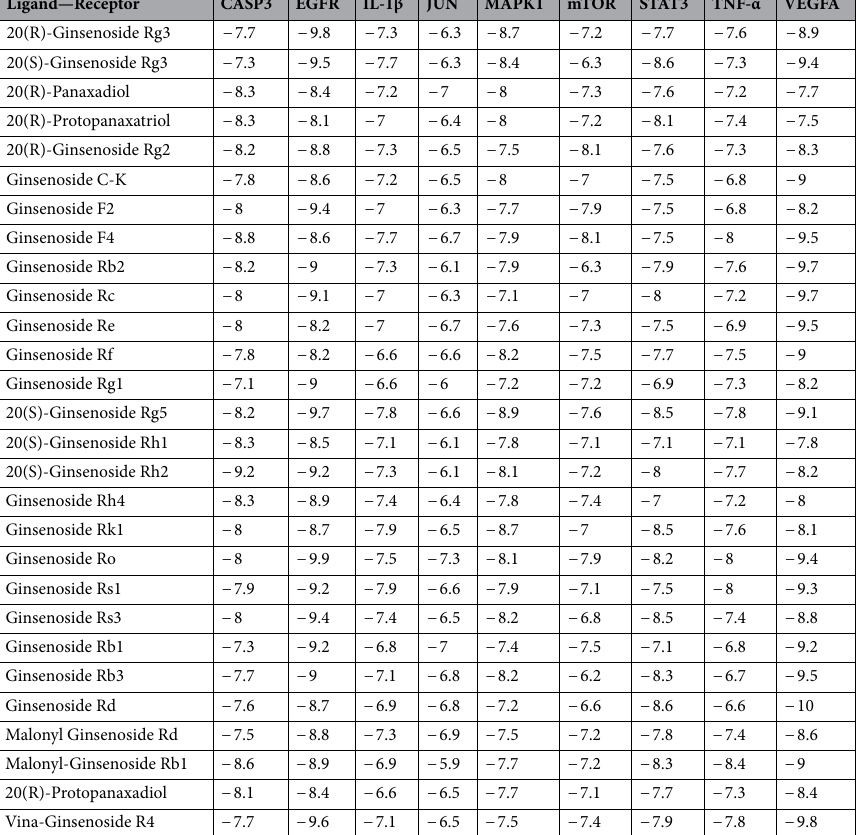
Table 3. Molecular docking binding energy of ligand with receptor